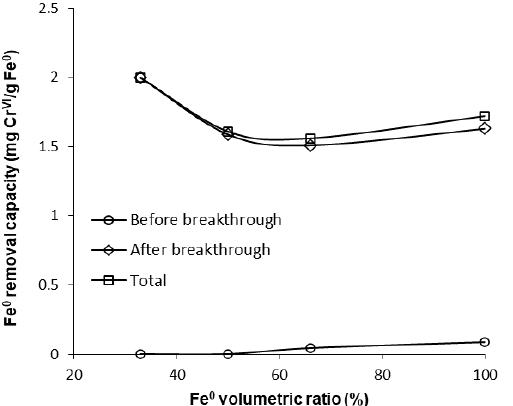
Figure 9 . Cr VI removal capacity of Fe 0 at pH 6.5 for columns having fixed Fe 0 volume and variable total reactive zone volume V 2 .